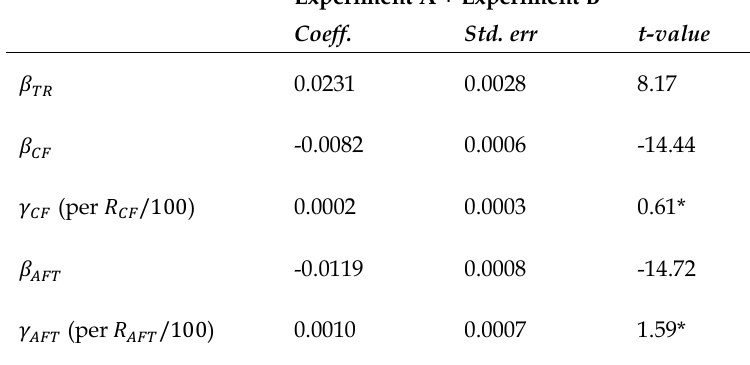
Estimation results of the reference-point